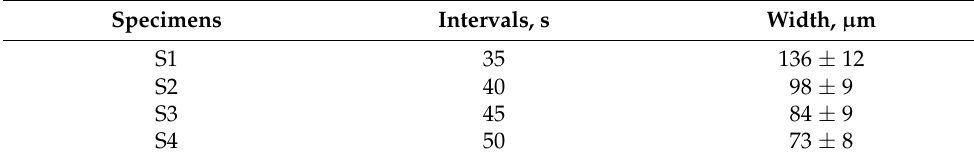
Table 2. The interfacial width of specimens for different intervals inferred from EDS.